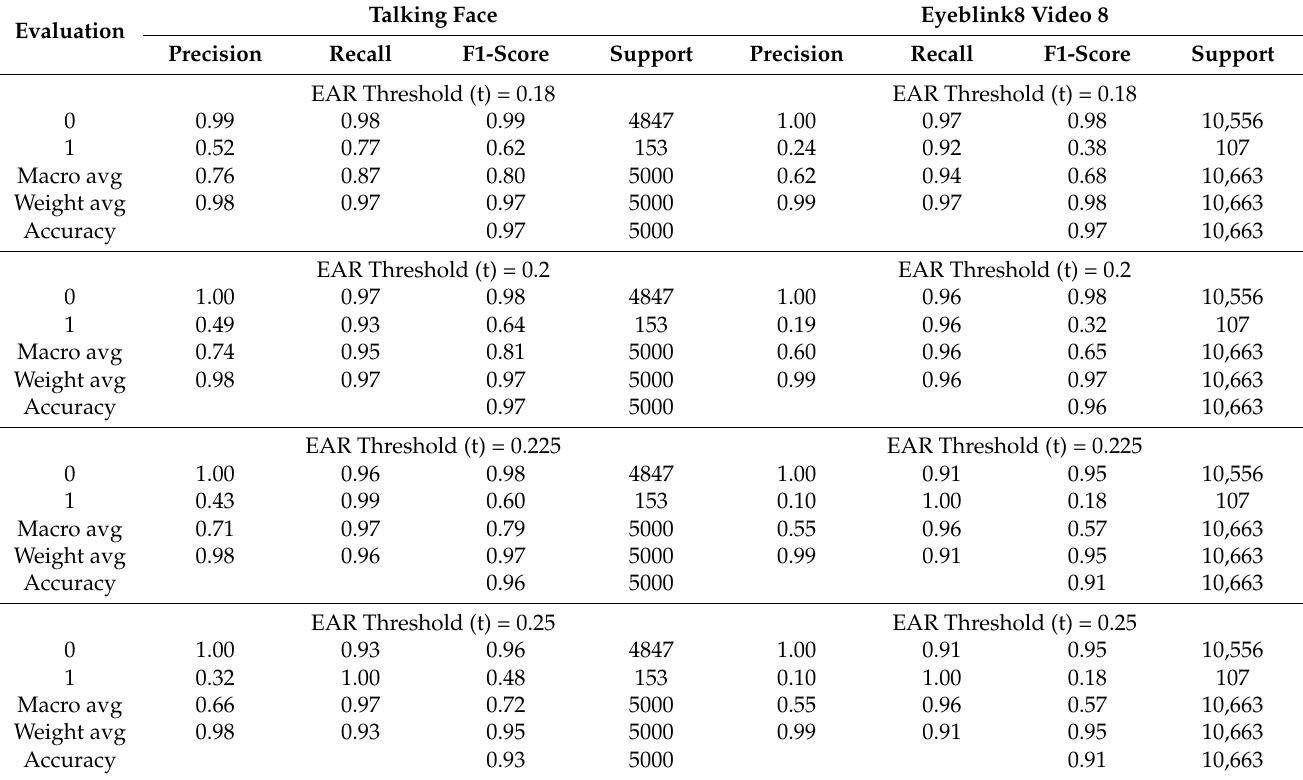
Table 6. Precision, recall, and F1-score (Talking Face and Eyeblink8